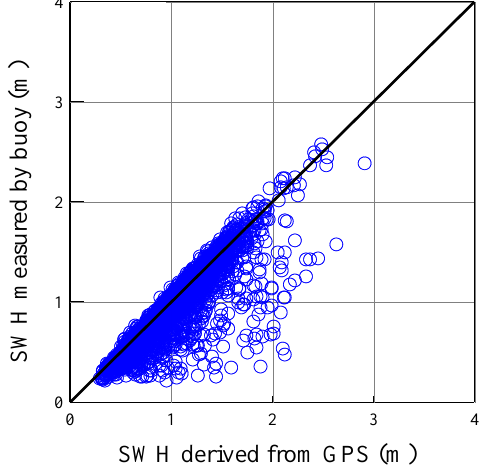
Figure 9. Comparison of significant wave heights from GPS derived and Buoy’s Accelerometer.